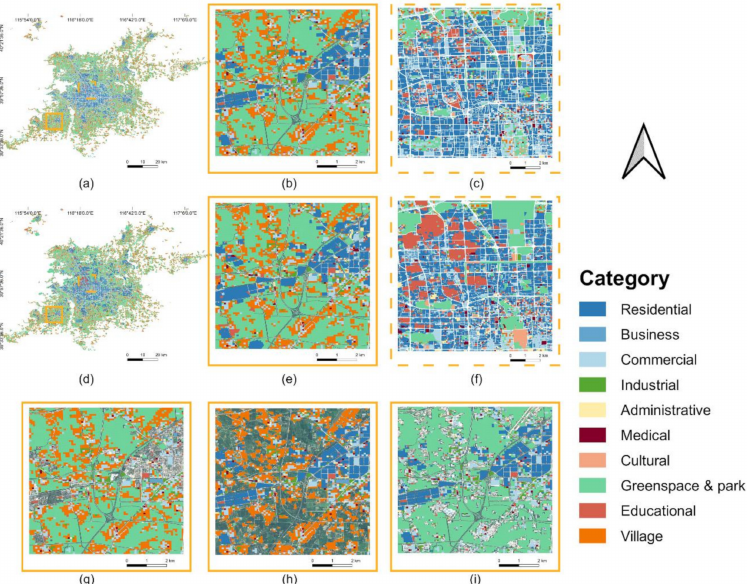
Figure 19. Comparison and zoomed-in views of EULUC-AOI (OSM+100 m grid) in Beijing, 2019s. ( a ) The mapping results before overlaying the AOIs layers; ( b , c ) zoomed-in views of ( a ); ( d ) the mapping results after overlaying the AOIs layers; ( e , f ) zoomed-in views of ( d ); the zoomed-in views with solid lines outside shows details in the solid box in the lower-left corner of the mapping results. The zoomed-in view with dashed lines outside shows details in the dashed box near the middle of the mapping results. ( g – i ) The results of ( b ) with the removal of residential, greenspace, and village units in turn, with Sentinel II optical images in the background.